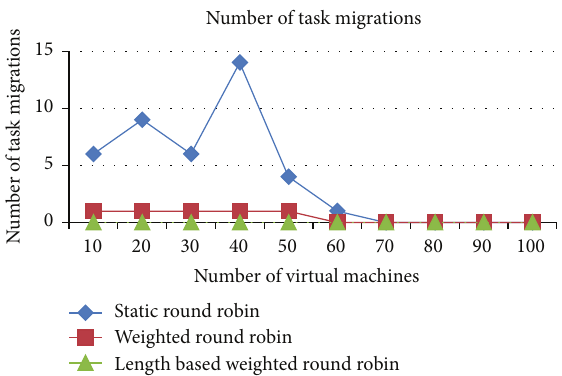
Figure 6: Number of task migrations (space